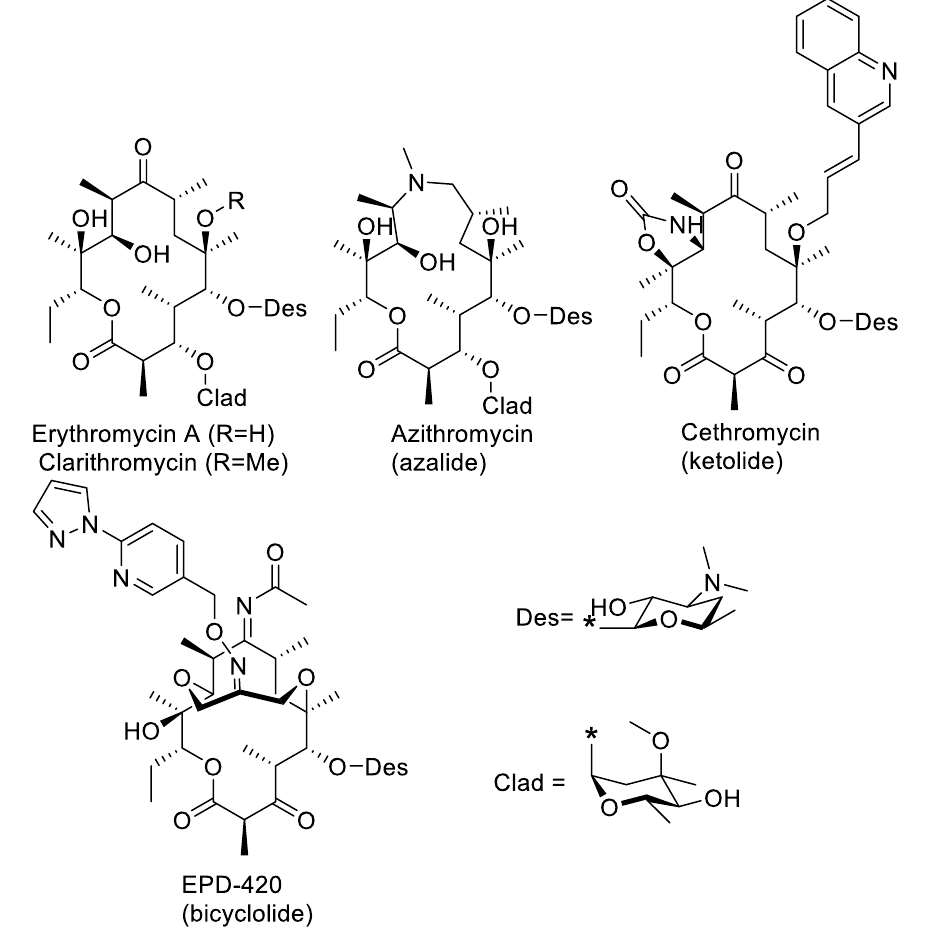
Figure 1. Overview of important of polyketide